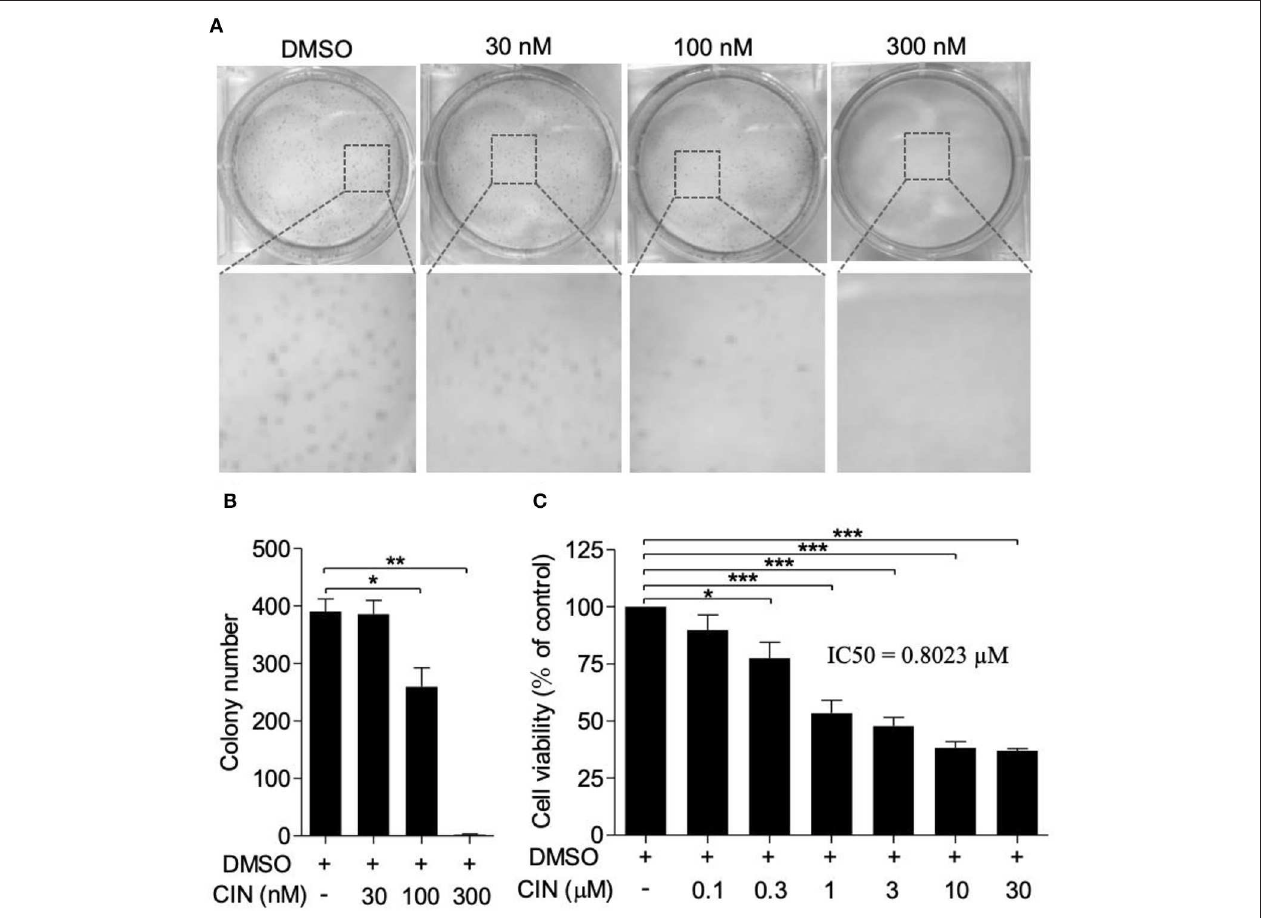
FIGURE 1 | Cinobufagin inhibits OCM1 cell proliferation. (A) Colony formation assay was used to determine the inhibitory effect of cinobufagin (CBG) on OCM1 proliferation. Representative images of colonies from six-well plates by colony formation assay. OCM1 cells were treated with 0, 30, 100, and 300nM CBG for 1 week. (B) Quantification of the colony number of OCM1 cells. (C) CCK-8 assay was used to detect the toxicity of CBG after treatment for 48h on OCM1 cells. The IC50 was calculated to be 0.8023 µ M. The results are expressed as the mean ± SEM of three independent experiments [ n = 3, * P < 0.05, ** P < 0.01, and *** P < 0.001 compared with the dimethyl sulfoxide (DMSO)